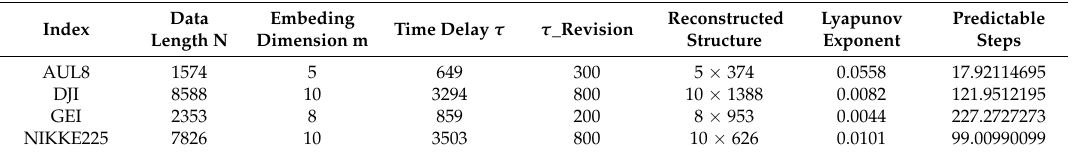
Table 1. Structural information of four datasets by PSR.